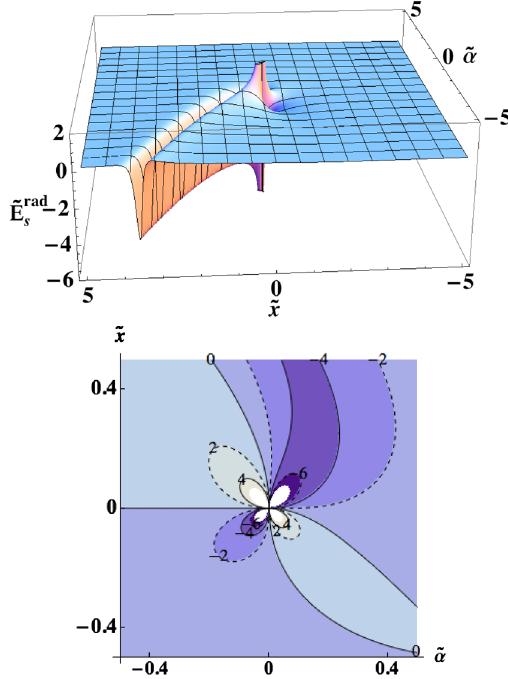
ð ~ (cid:4); ~ x Þ ¼ s